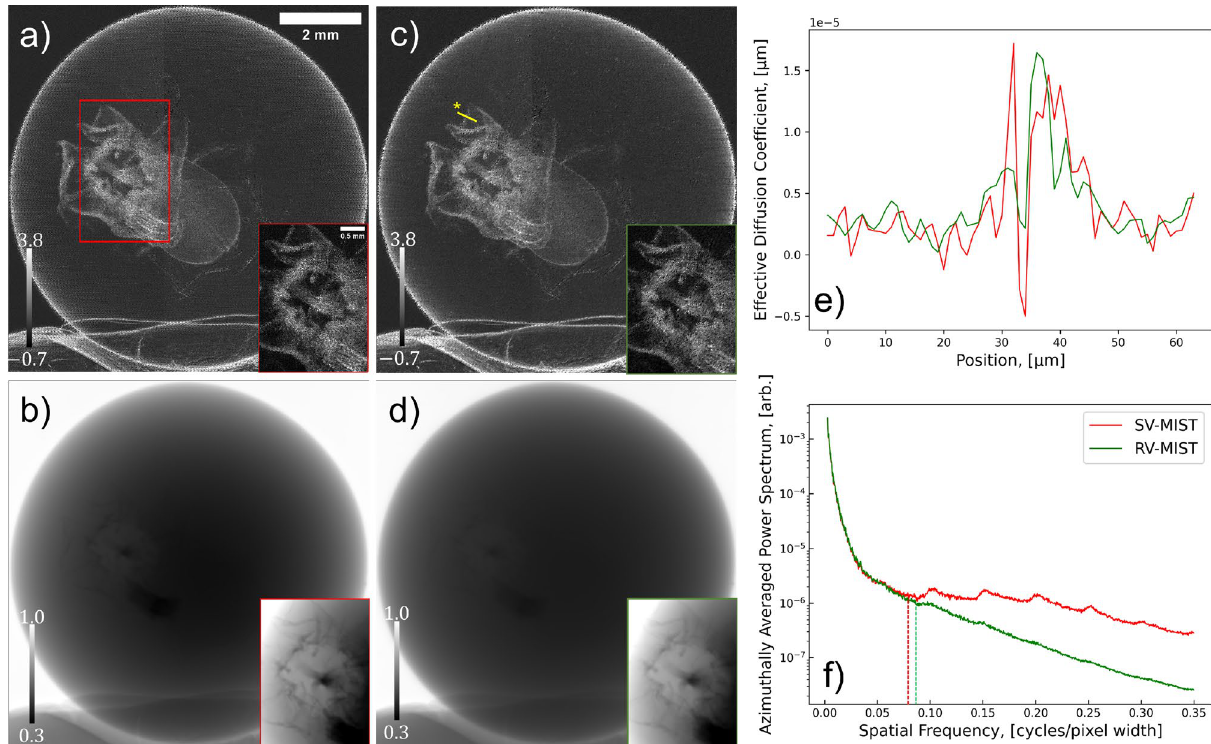
Figure 6. Comparison of the red currant’s multimodal signals extracted using the approach published in Alloo et al. 42 , ( a , b ), which assume the red currant’s effective diffusion coefficient is slowly varying (SV-MIST), and those presented within this study, ( c , d ), which have no assumptions regarding the effective diffusion coefficient (RV-MIST). The effective diffusion coefficient reconstructions are shown in ( a , c ), and the currant’s attenuation term is shown in ( b , d ). The yellow-asterisk line profile in ( c ) is shown in ( e ), and ( f ) shows the azimuthally averaged power spectra. The vertical dashed lines in ( f ) denote the approximate knee of the respective power spectra. The greyscale bars in ( a , c ) are × 10 − 5 µ m. The displayed greyscale ranges for the subfigures’ magnified regions ( a – d ) are [0.01–2.09] × 10 − 5 µ m, [0.35–0.51], [0.08–1.79] × 10 − 5 µ m, and [0.38–0.46],